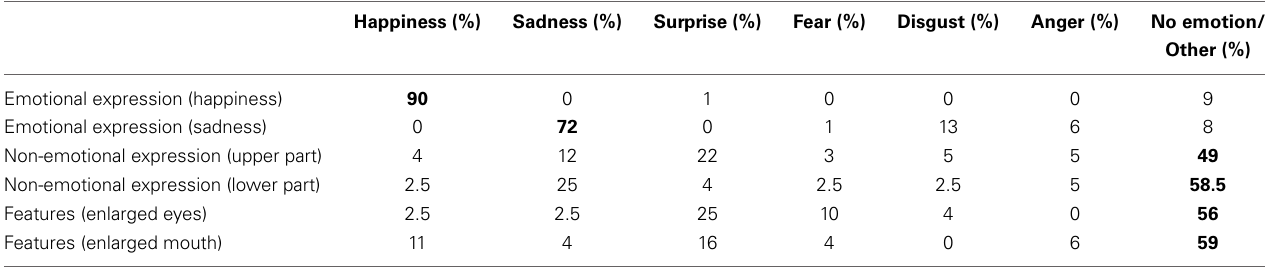
Table 2 | Mean percentage (%) of emotional and non-emotional ratings given to each type of modified stimulus. Happiness